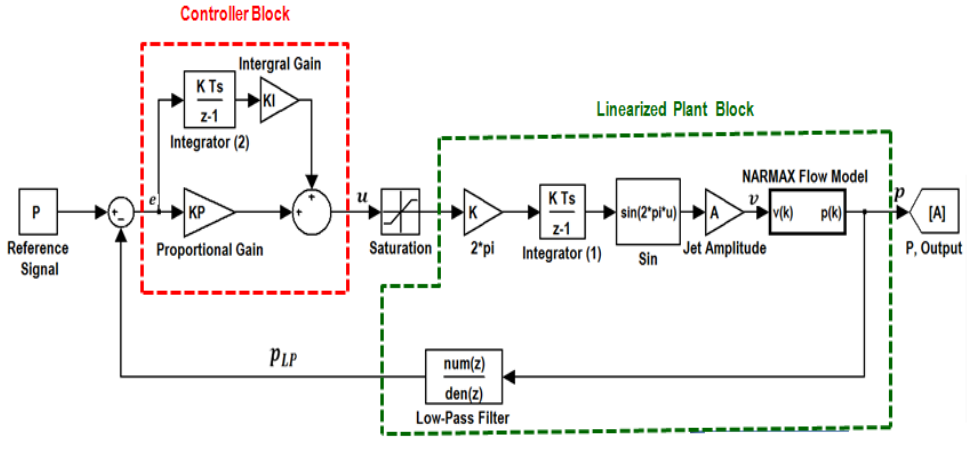
Figure 15. Simulink diagram for PI feedback control.